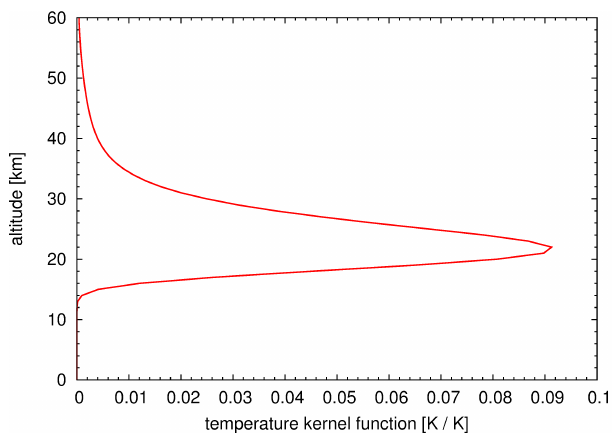
Figure 1. The temperature weighting function (brightness temper- ature (K) / temperature (K)) for the 666.5cm − 1 AIRS channel. This function was calculated for a polar winter reference atmosphere, a 1km altitude grid, and the nadir observation geometry.